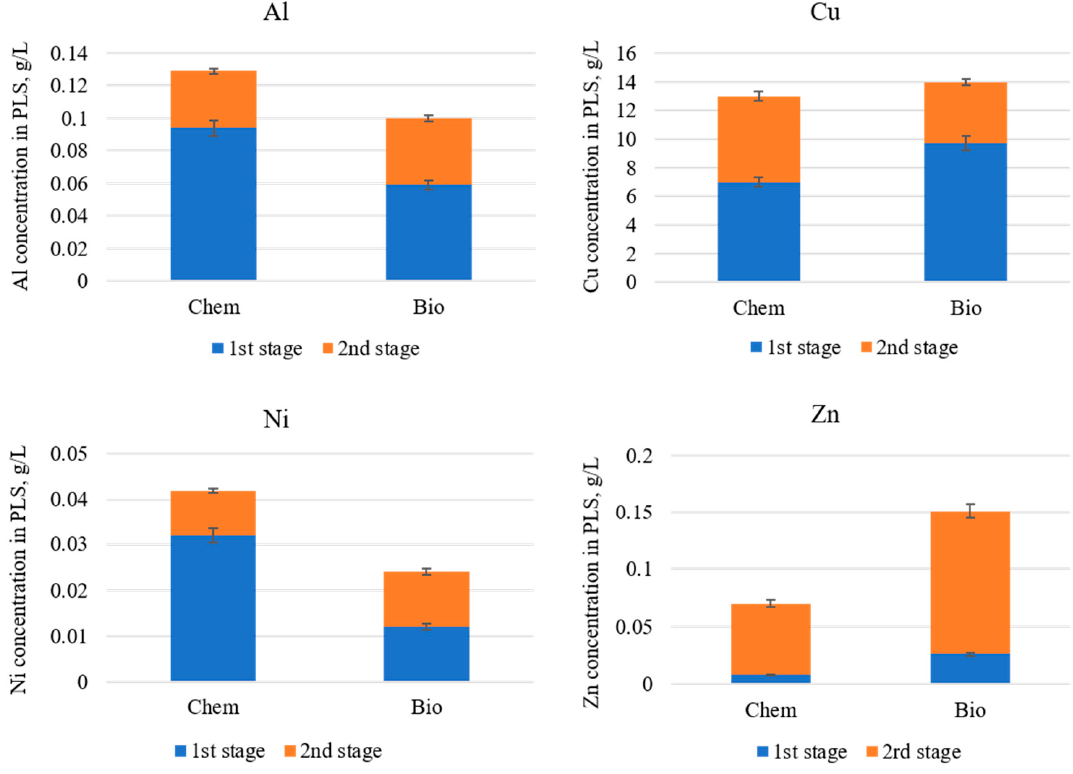
Figure 7. Cumulative metal content of the pregnant leach solution (PLS) after two-stage leaching with bio- and chemically generated Fe 3+ (PD 10%; initial pH 1.2; 40 °C; air 1 lpm; 600 rpm). with bio- and chemically generated Fe 3+ (PD 10%; initial pH 1.2; 40 ◦ C; air 1 lpm; 600